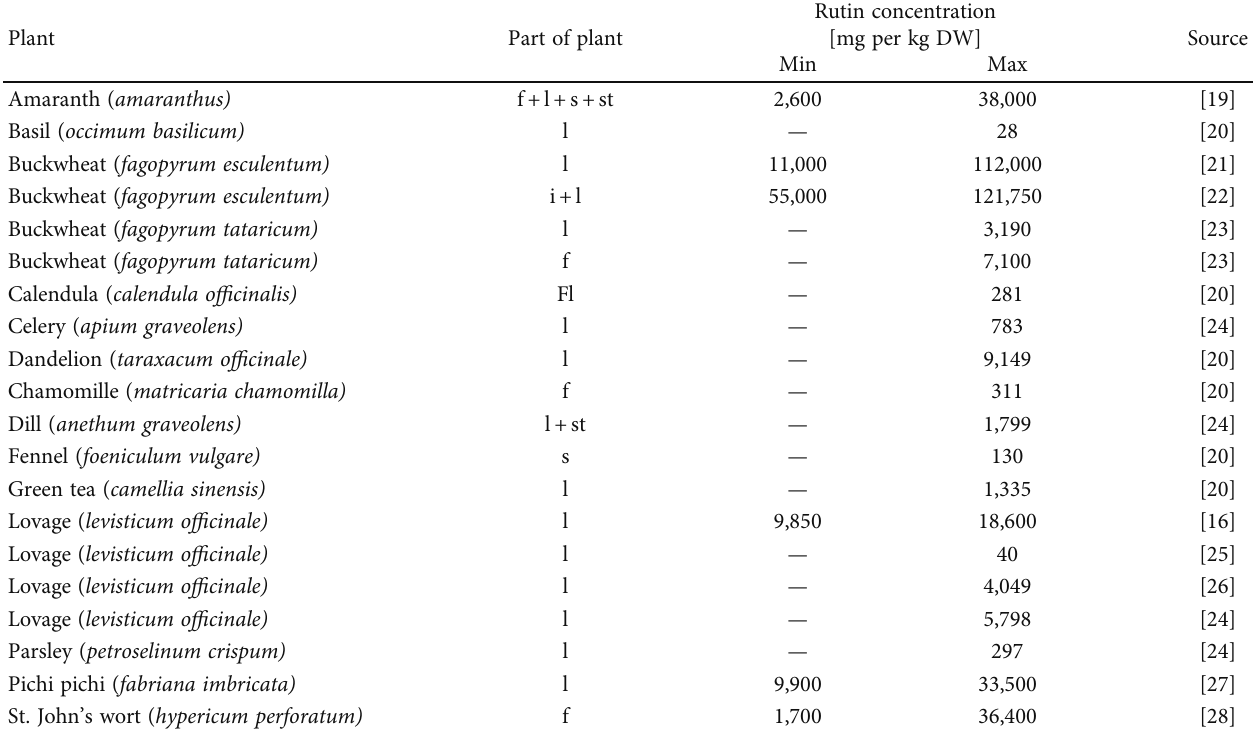
Table 2: Values of rutin concentrations found in di ff erent plants. DW: dry weight. Part of plant investigated: f: fl owers, i: in fl orescences, l: leaves, s: seeds, st: stems. Plant